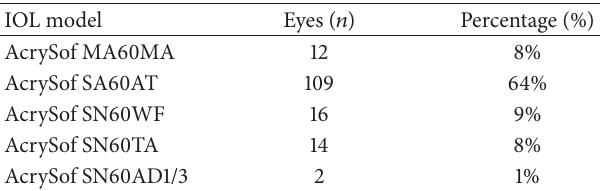
Table 2: Brand and model of the implanted